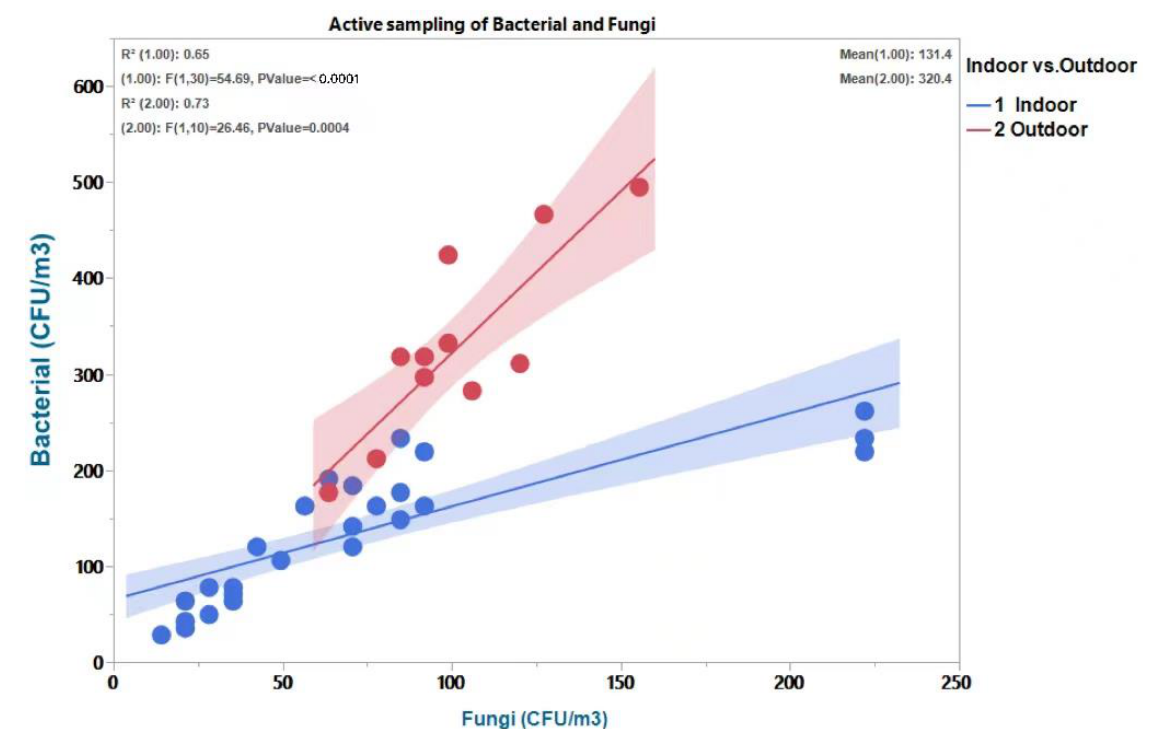
Figure 2. Bacterial count vs. fungal count from active sampling of air.